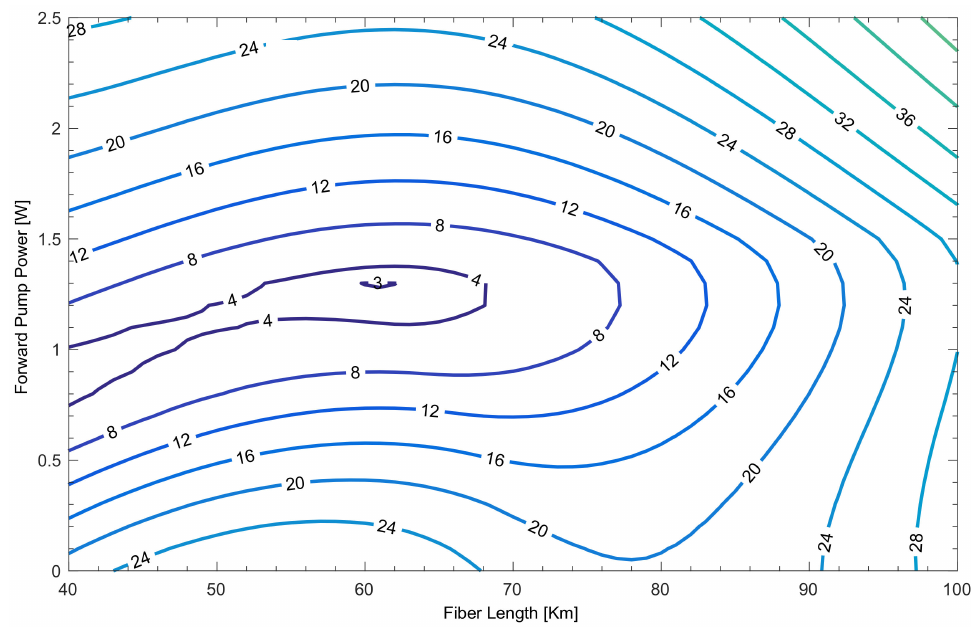
Figure 8. Signal power asymmetry (%) as a function of different span lengths and pump powers (backward pump power was adjusted to give 0 dB net gain).